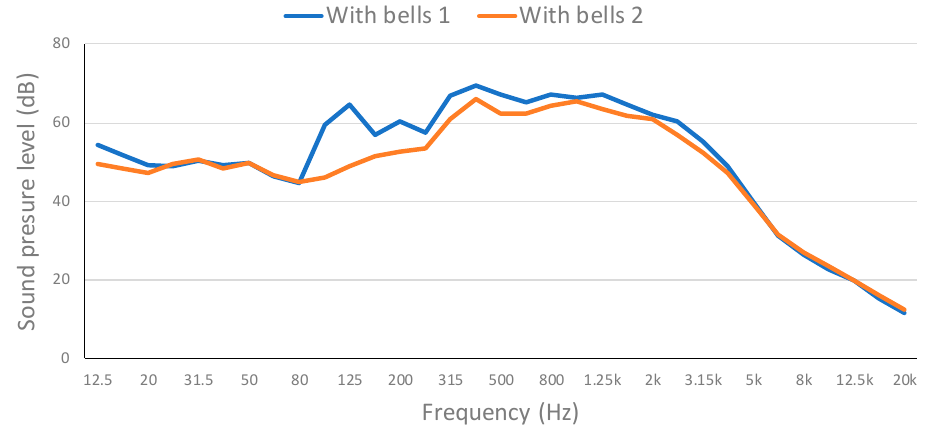
Figure 11. Evolution of the continuous sound pressure level for each frequency band in outside point 1.